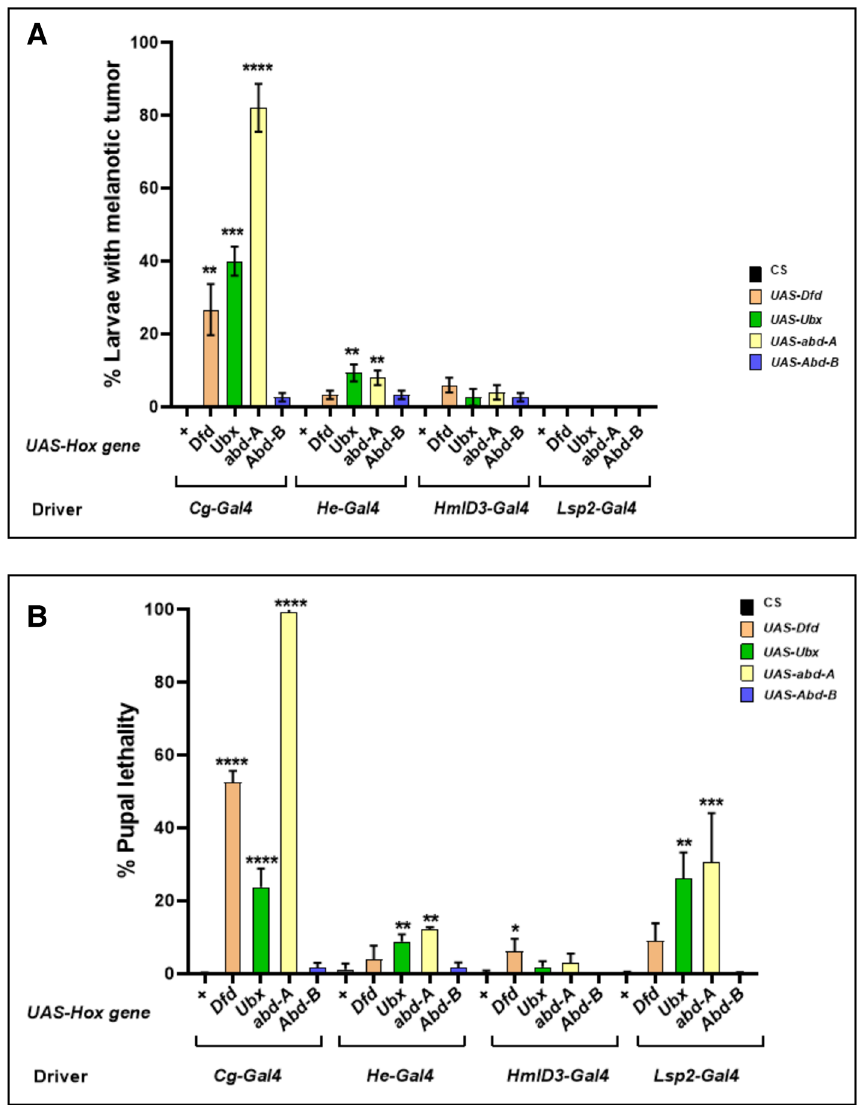
Figure 2. Tumor phenotype in larvae and pupal lethality. ( A ) The size and penetrance of melanized bodies was maximum when expressed under Cg , while tumors do manifest when He and HmlD3 are used, they are much rarer and smaller. Expression under Lsp2 - Gal4 does not lead to the formation of such bodies. ( B ) Percentage of pupal lethality, indicated by larvae that fail to eclose. When Cg-Gal4 drives the genes Dfd, Ubx, abd-A and Abd- B do cause lethality, so does expressing them in the fatbody under Lsp2 - Gal4 . Driving these genes in the blood cells ( He - Gal4 and HmlD 3- Gal4 ) leads to a much lower penetrance of this